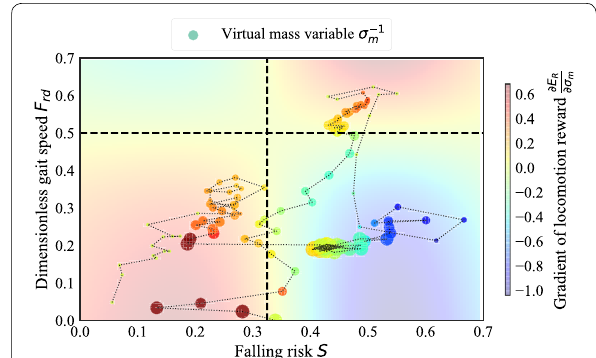
Fig. 15 Verification of behavior of VM-SAL the plotted data has the size based on σ − 1 m and the color based on the change of σ m ; on the slope, the state was kept in the region 3 to prevent speed fluctuation; the region 2 was hardly visited because running with high speed tends to be risky